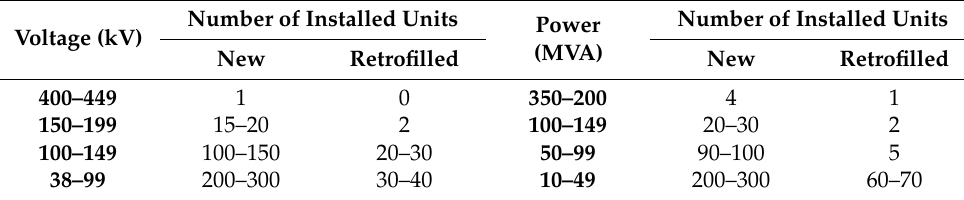
Table 1. Number of transformers filled with ester fluids worldwide (2014). Data taken from [3]. Number of Installed Units Voltage (kV)